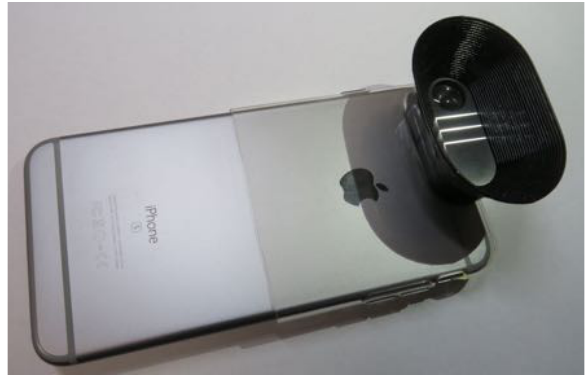
Figure 3. Front view of the proposed system.